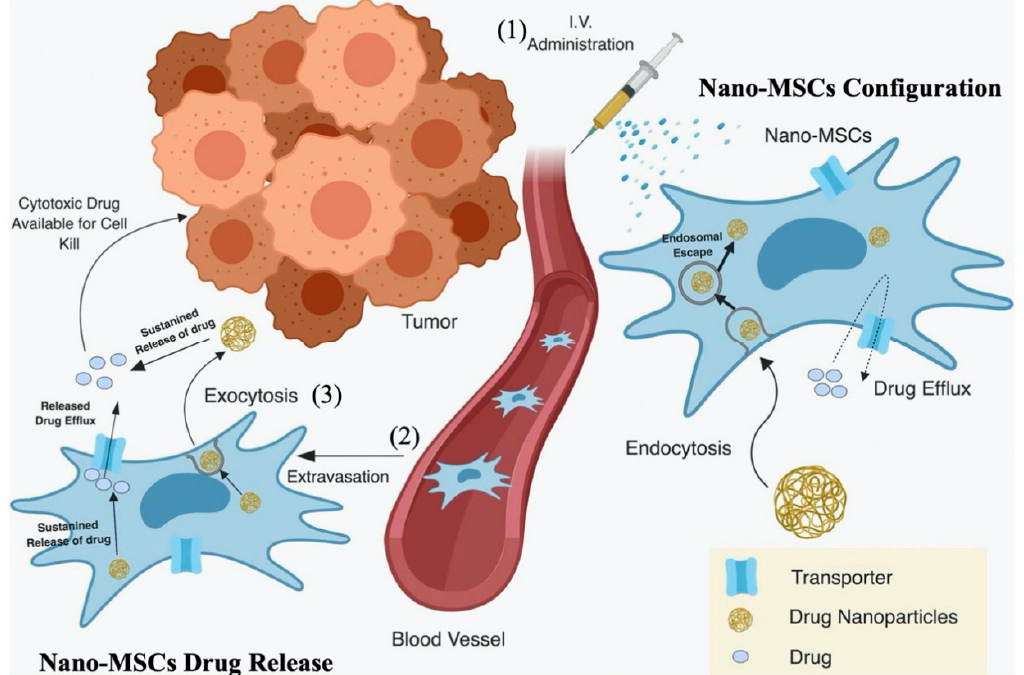
Figure 1. Schematic picture for the hypothetical mechanism of the action of nano-engineered mesenchymal stem cells (nano-MSCs). Following an intravenous (IV) administration of nano-MSCs (1), despite the immature release of free paclitaxel (PTX) and paclitaxel poly (lactide-co-glycolide) nanoparticles (PTX-PLGA NPs) from nano-MSCs in the plasma, PTX was rapidly carried by MSCs towards tumor-bearing sites by either active migration and extravasation or passive retention (2). PTX-PLGA NPs were then slowly exocytosed from MSCs into interstitial fluid (3). The released PTX-PLGA NPs can diffuse across the interstitial space and be taken up either by tumor cells to induce anti-tumor efficacy or by tissue cells to induce off-target effects. The PTX free drugs released from PLGA NPs inside and outside MSCs can also introduce either efficacy or toxicity. Reproduced with permission from [2], ASEPT,